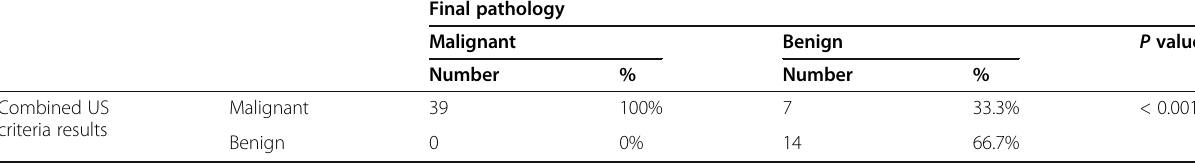
Table 1 Relation between the combined US criteria results and final pathology results